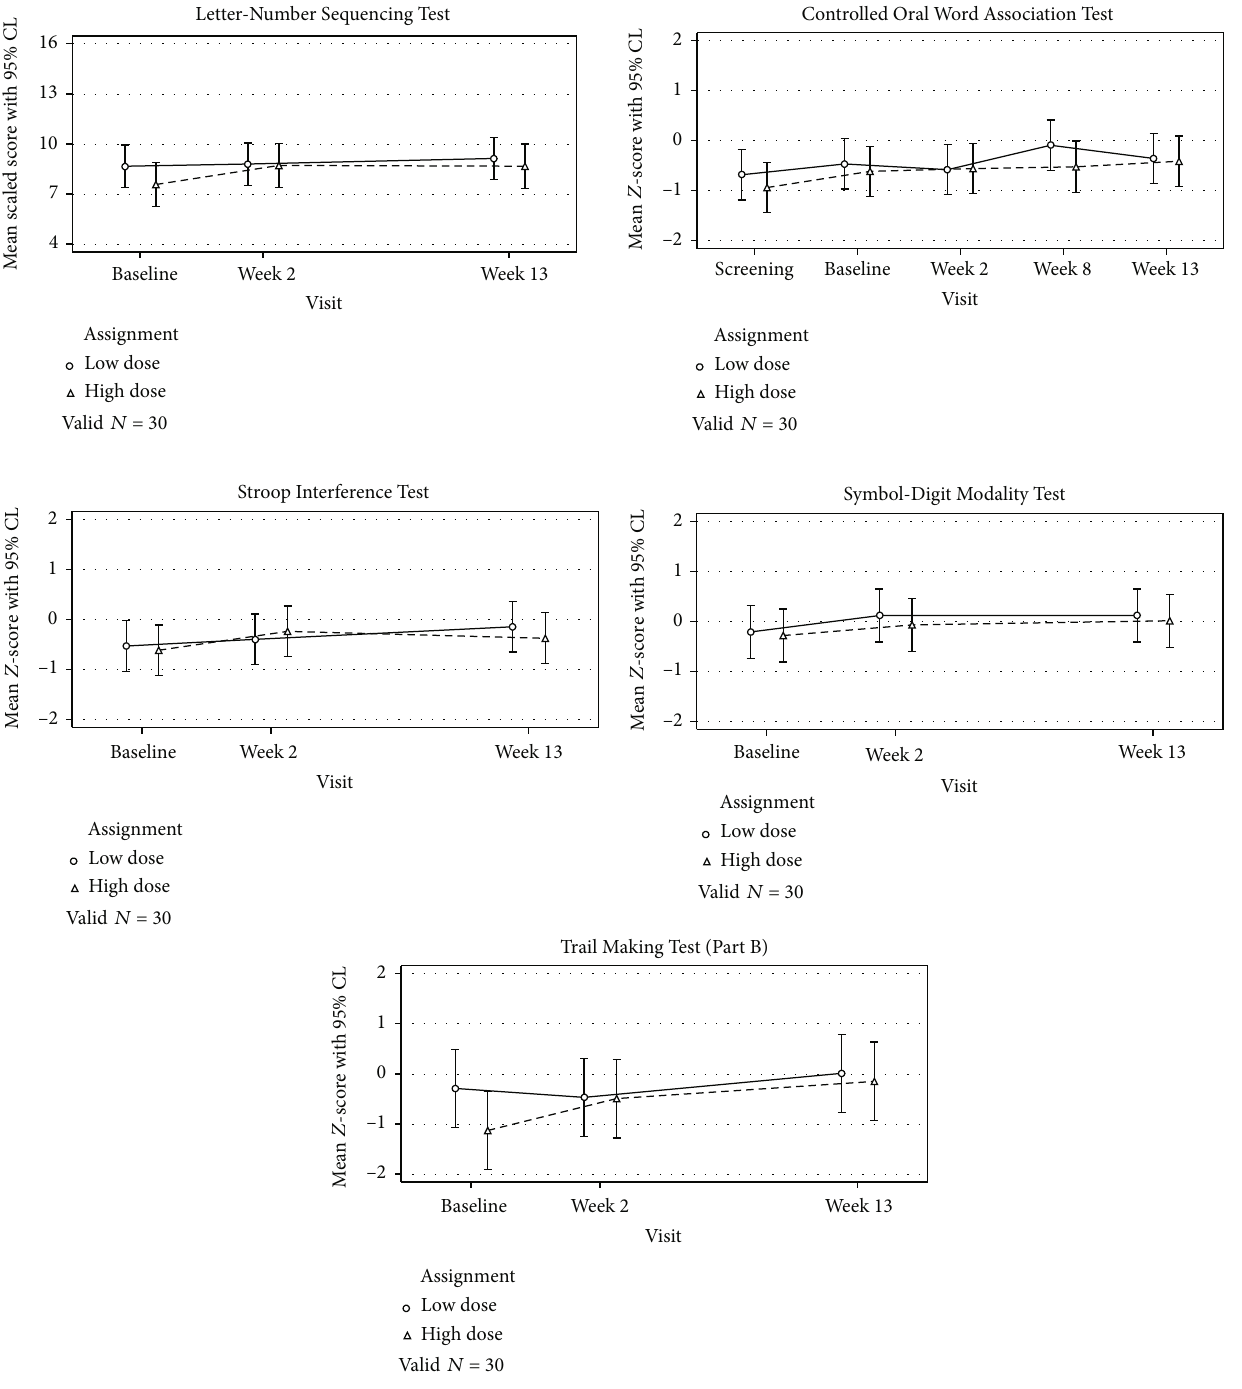
Figure 2: Executive functioning performance over